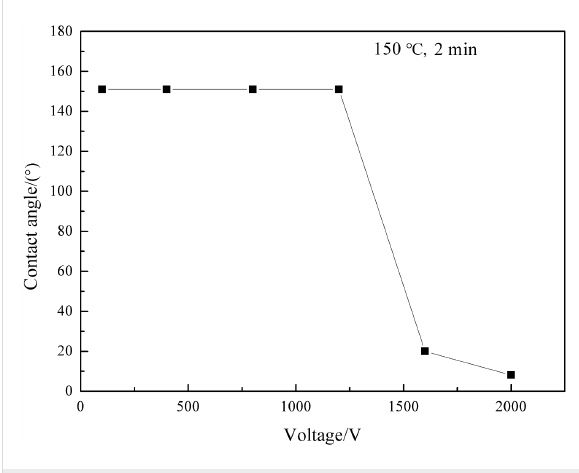
Figure 4: Changes in the contact angle as a function of voltage for the coating ( T = 150 °C, t = 2 min). (0.07–1.29 V). However, the surface potential in the electrode contact area remained almost constant ( − 0.25 V to − 0.24